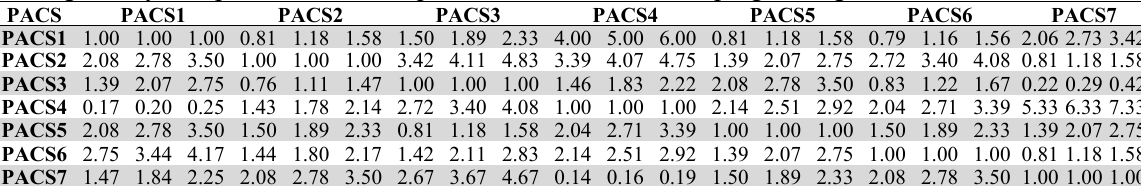
Average fuzzy comparison matrix of positive action-focused coping strategies PACS PACS1